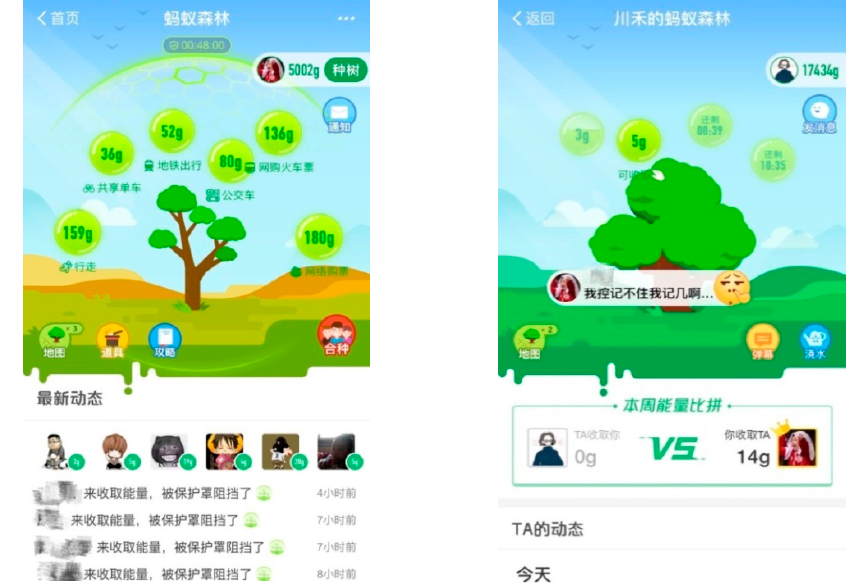
Figure 1. Sample Ant Forest interfaces.